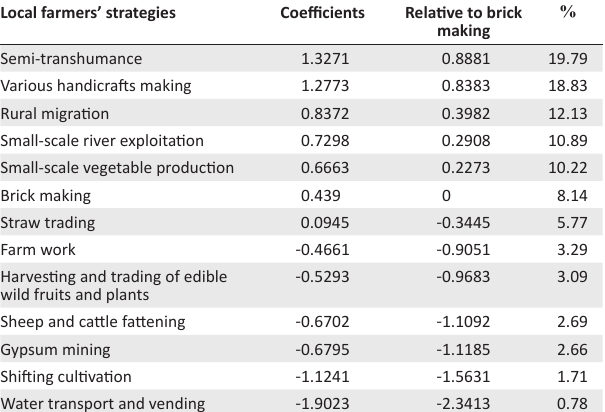
TABLE 4: The relative importance of each strategy compared with brick making.